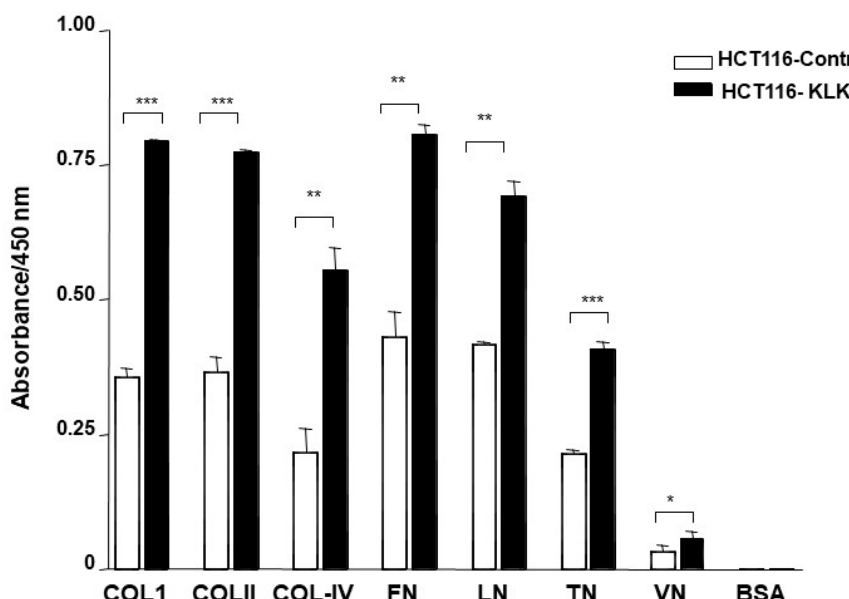
Figure 6. Effect of KLK6 knock down on cell adhesion. The adhesion assay was performed by seeding HCT116-KLK6-KO and HCT116-control cells (10 5 cells each) in 96-well plates coated with type I collagen (Col-I), type II collagen (Col-II), type IV collagen (Col-IV), fibronectin (FN), laminin (LN), tenascin (TN), or BSA as a negative control. Cells were incubated for 2 h. Non-adherent cells were washed three times with PBS, the attached cells were then stained using the ECM Cell Adhesion Array Kit and quantified by absorbance readings in a microplate reader at 570 nm. Means of three independent experiments are presented. Data are shown as mean ± SEM. * p < 0.05; ** p < 0.01; *** p < 0.001.